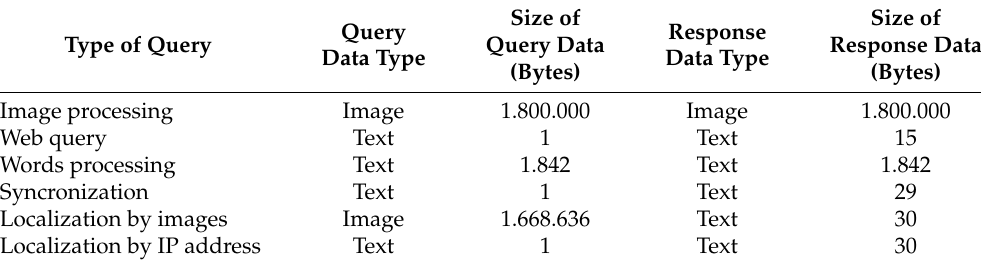
Table 10. Used data set in experiments.